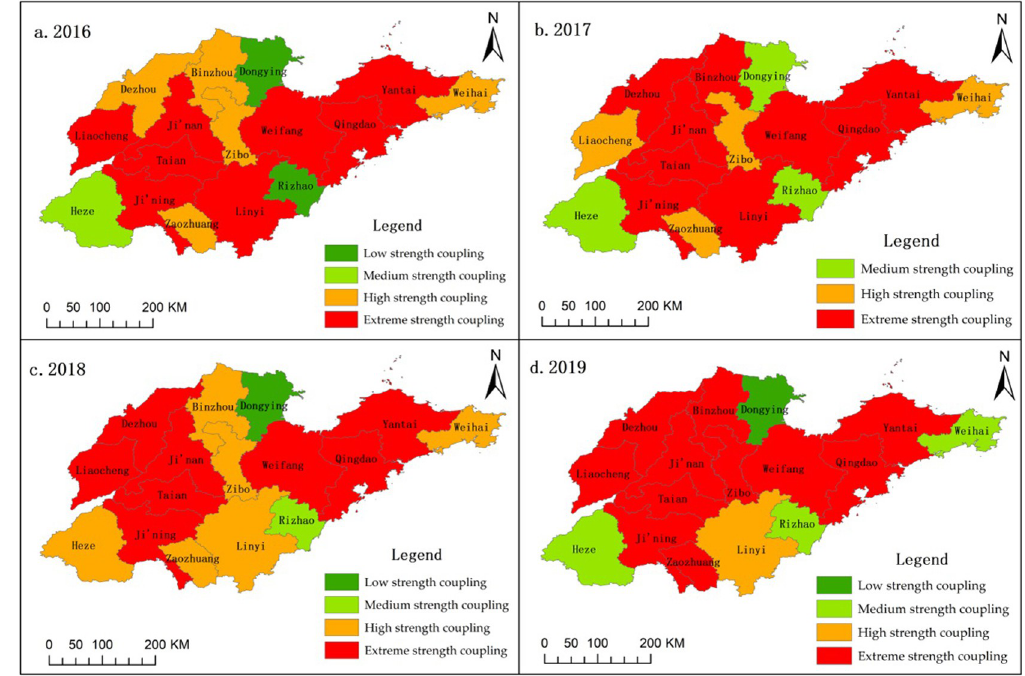
Fig 2. Spatial distribution pattern of coupling degree between urban agricultural informatization and agricultural economic development in Shandong Province, 2016 to